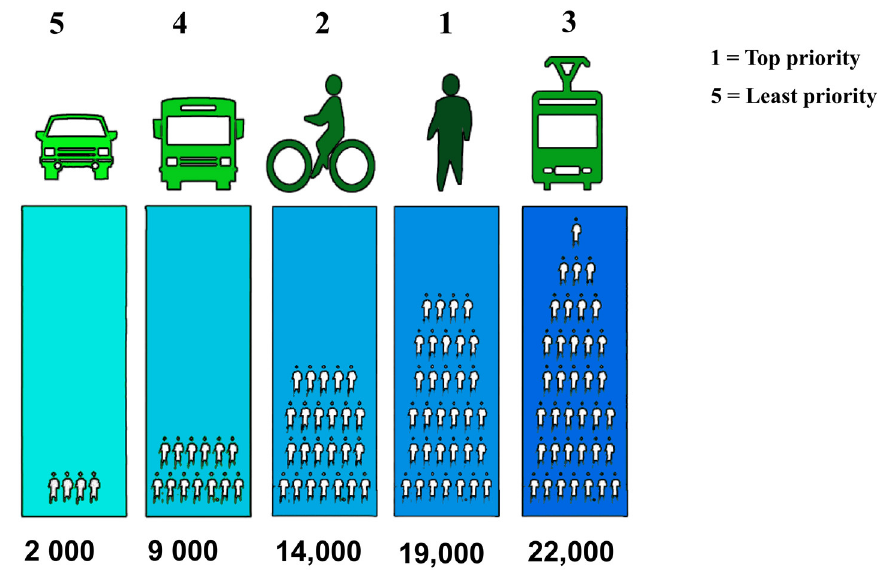
Figure 12. The graph shows the green transportation priority scheme in relation to number of people crossing a 3.5 m (11.5 ft)—wide space during a one-hour period